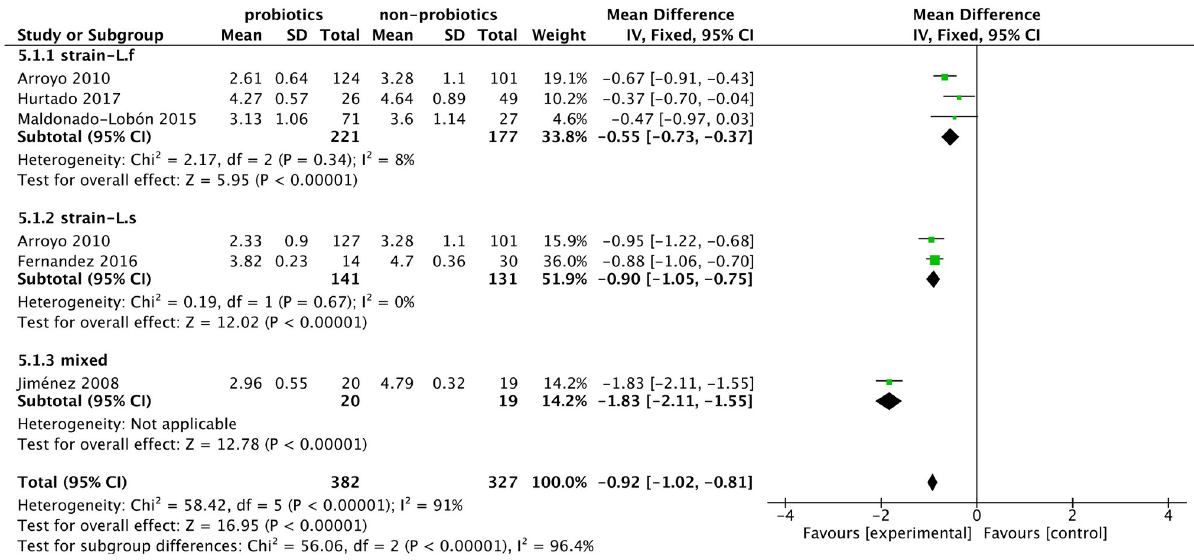
Fig 8. Forest plot of the subgroup analysis of bacterial counts in mastitis